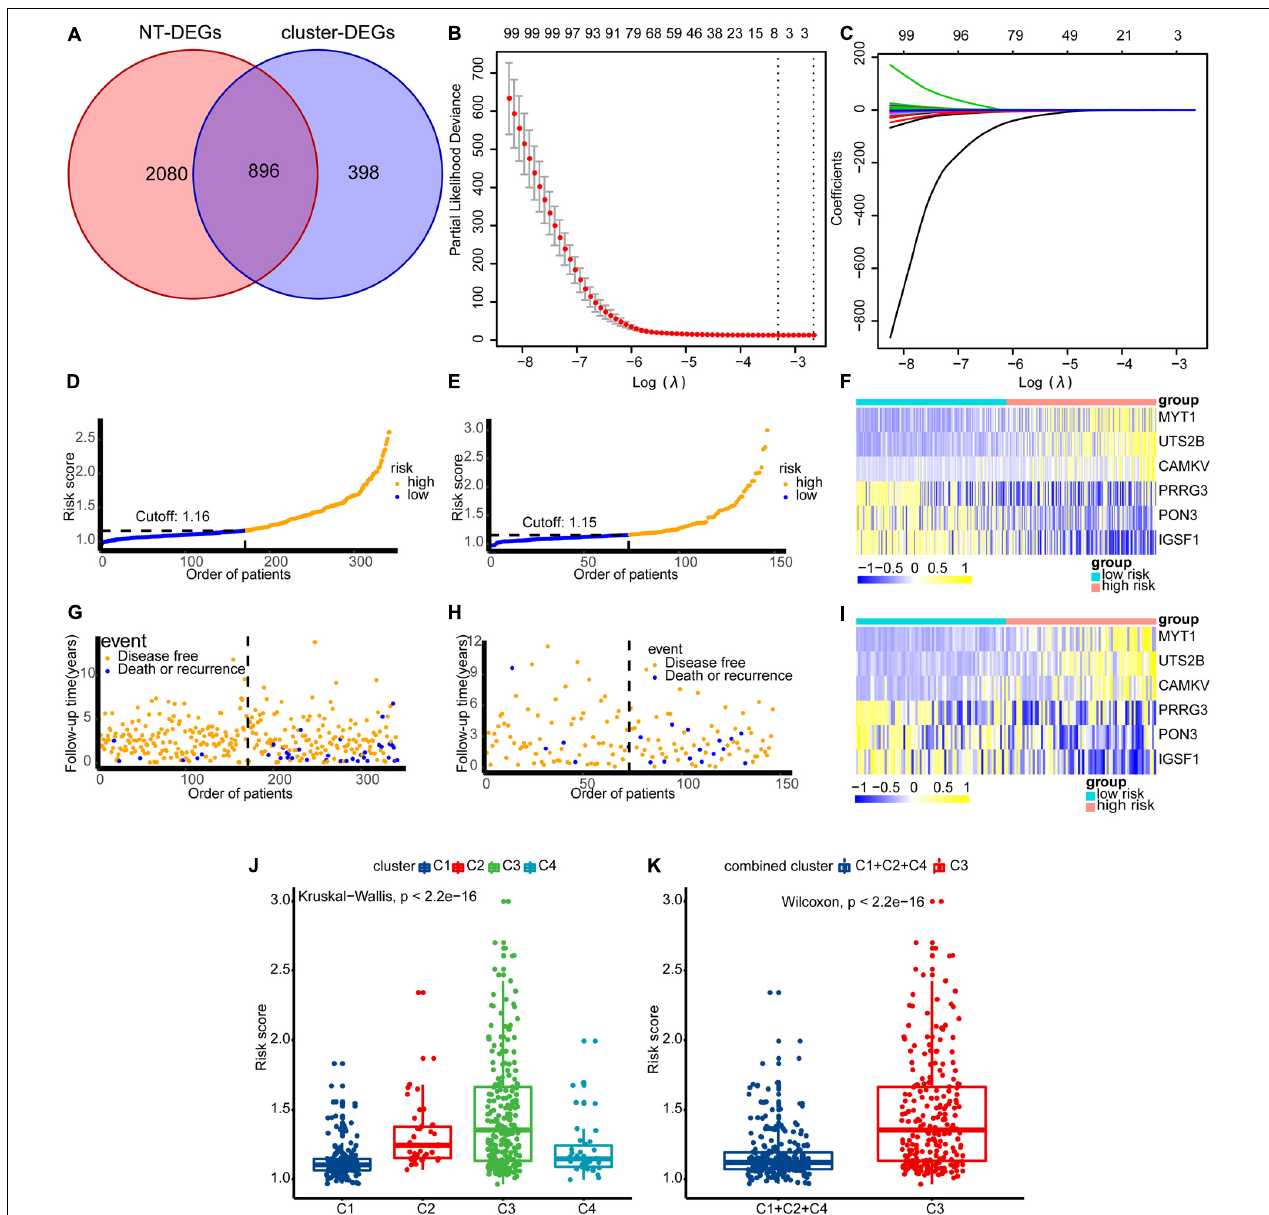
FIGURE 7 | Build the model and see how the model is performing in each dataset. (A) The intersection of NT-DEGs and cluster-DEGs served as the input for LASSO regression. (B) The λ value corresponding to minimal misclassification error in cross validation. (C) Based on the value of λ , the gene signatures and their coefficients of the model were obtained. (D,G,F) The results in the training set. (E,H,I) The results in the internal validation set. (D,E) The distribution of population risk scores and risk classification based on the cut-off value. (G,H) The relationship between the survival outcome and risk classification of patients. Low-risk patients are shown on the left side of the dotted line and high-risk patients are shown on the right side. (F,I) Heat maps for the gene signatures. (J) The difference in risk scores between the four subtypes (C1, C2, C3, and C4). (K) The difference in risk scores between the high-risk (C3) group and the low-risk (C1 + 2 + 4) group. NT-DEGs, the differentially expressed genes (DEGs) between the normal prostate tissue and the prostate tumor tissue; cluster-DEGs, the differentially expressed genes (DEGs) between the high-risk subtype (C3) and the low-risk subtype (C1 + 2 + 4); LASSO, least absolute shrinkage and selection operator; λ , punish coefficient.